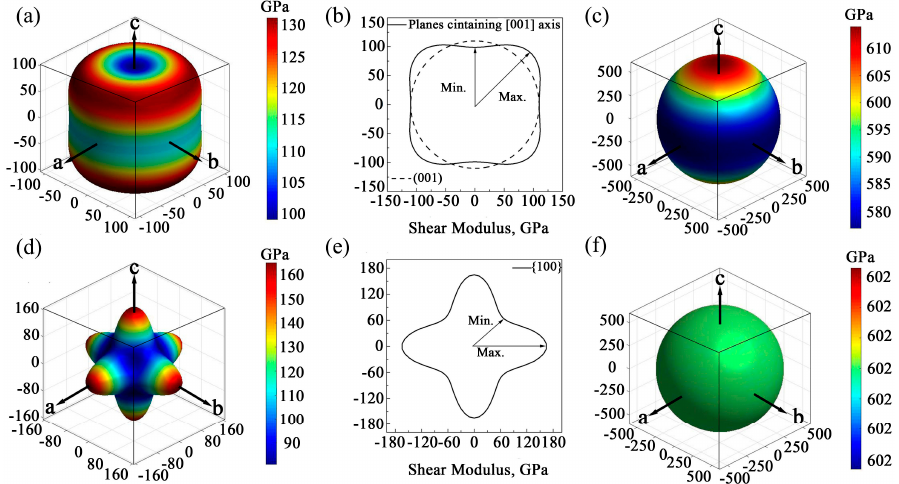
Figure 3. Directional dependence of elastic properties: ( a ) shear modulus of wurtzite GaN; ( b ) the projection of shear modulus of planes containing [001] axis in the wurtzite GaN; ( c ) bulk modulus of wurtzite GaN; ( d ) shear modulus of zinc-blende GaN; ( e ) the projection of shear modulus of planes {100} in the zinc-blende GaN; and ( f ) bulk modulus of zinc-blende GaN.